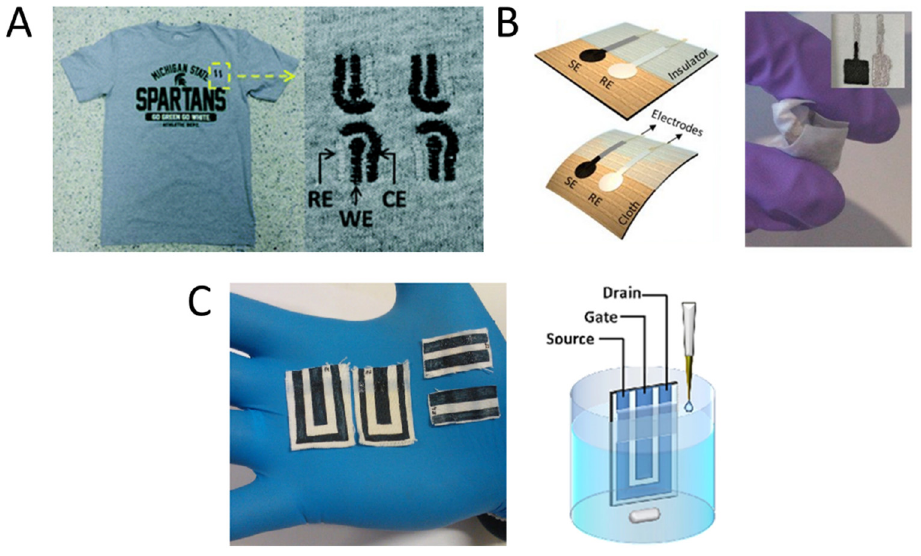
Figure 1. Examples of different kinds of electrochemical textile sensors. ( A ) Example of a textile amperometric sensor [17]. An amperometric sensor exploits the current associated to a redox reaction occurring at a working electrode (WE) as the analytical signal. The WE potential is usually fixed with respect to a reference electrode (RE) and both electrodes must be immersed in the same solution. The most rigorous measurements are performed in a three-electrode cell endowed with a counter electrode (CE). Reproduced from Ref. [16] with permission from the Royal Society of Chemistry.